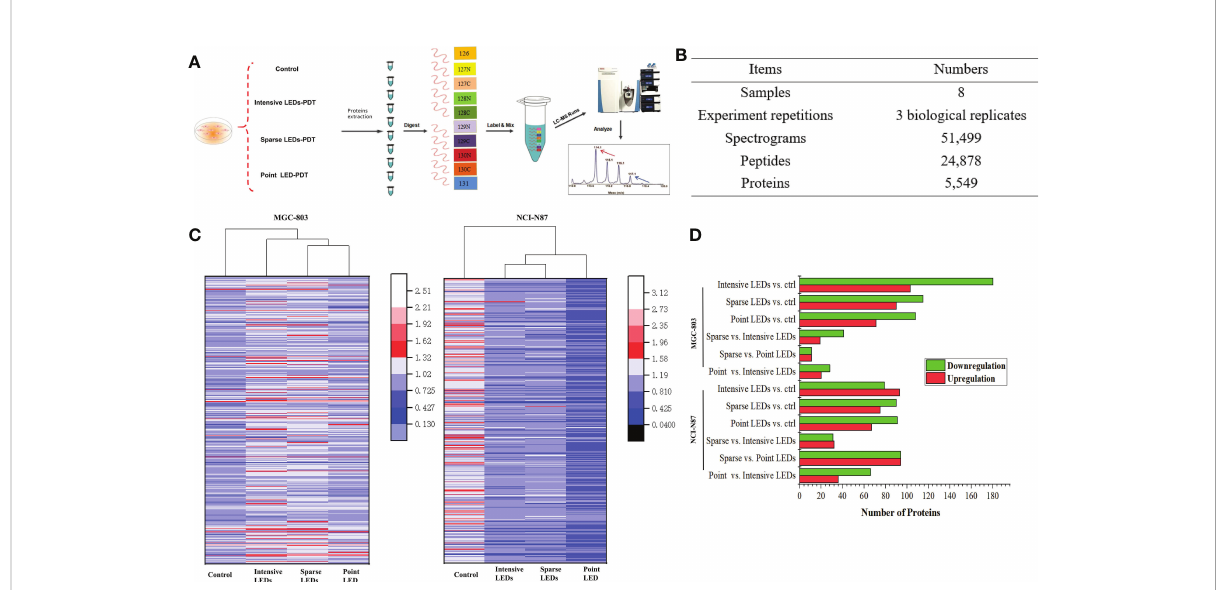
FIGURE 5 Proteomic analysis of GI cancer cells treated with intensive LED-PDT, sparse LED-PDT, and point LED-PDT, respectively. (A) The experimental procedure. (B) General information of the proteomic analysis. (C) Heat map analysis of 500 proteins with the most signi fi cantly altered expression levels. The heat map was produced using Origin. (D) Distributions of DEPs of paired comparisons among intensive LED-PDT, sparse LED-PDT, point LED-PDT, and control (ctrl) groups. Red and green represent upregulated and downregulated DEPs,